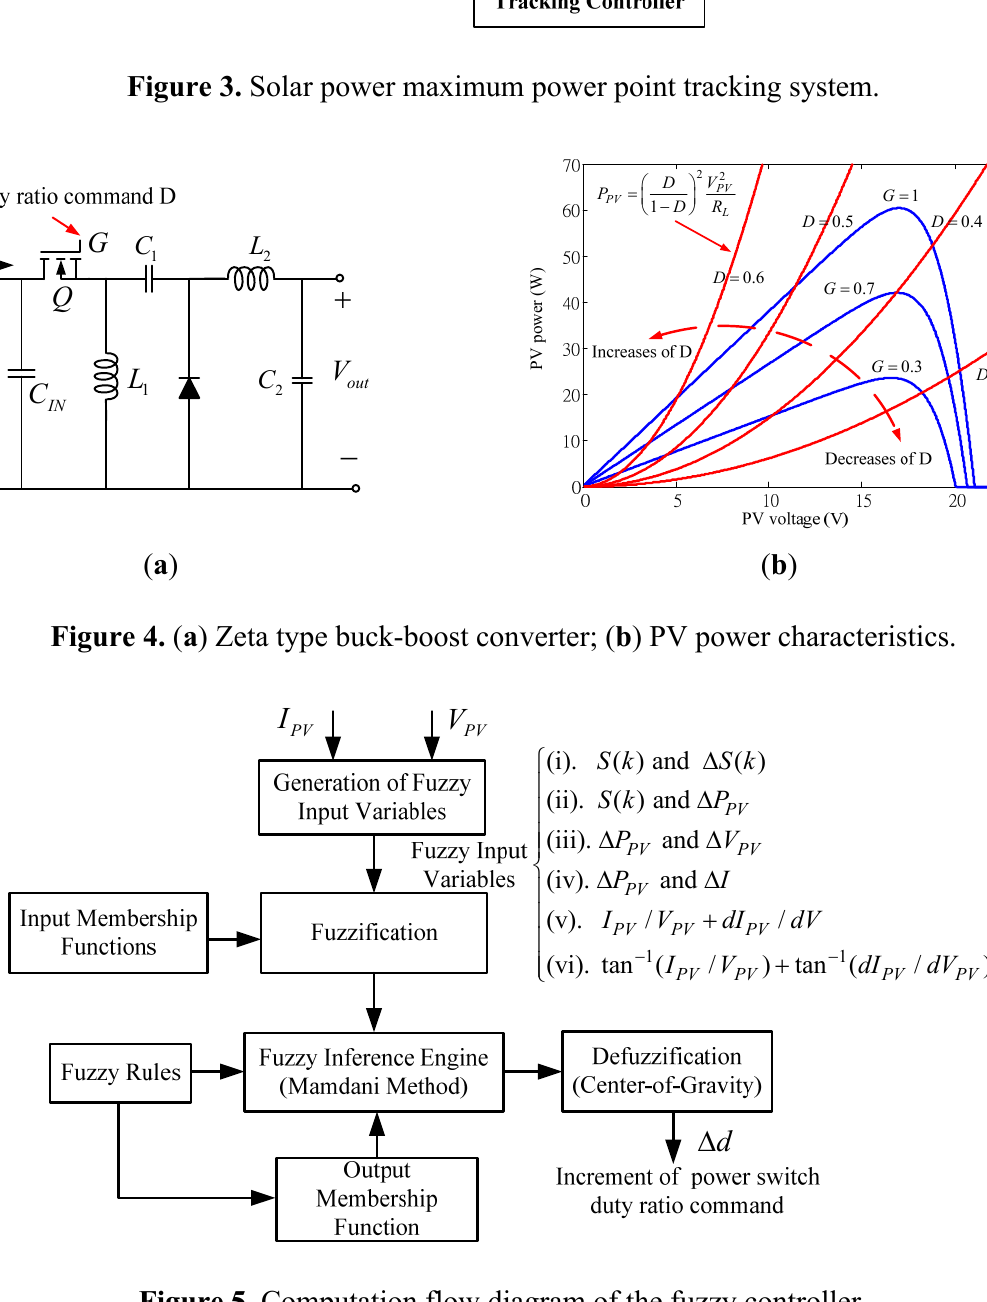
Figure 5. Computation flow diagram of the fuzzy